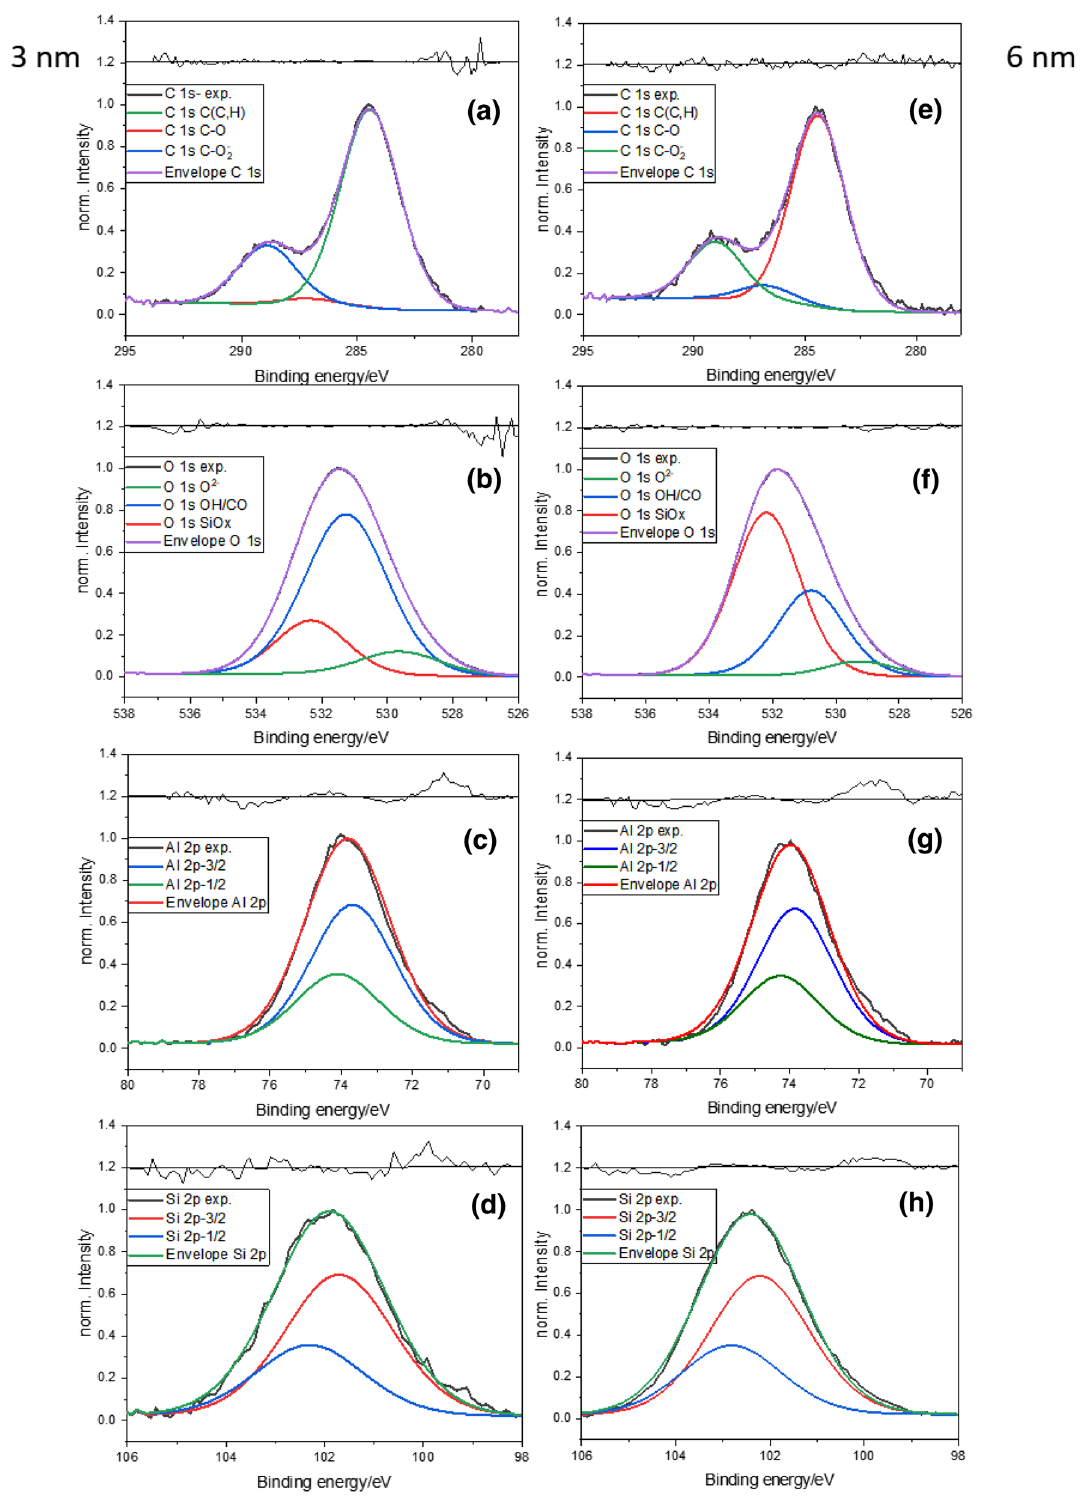
Fig. 4 XPS high-resolution spectra of C 1 s, O 1 s, Si 2p and Al 2p of the deposited SiO d = 3 nm and e – h d = 6